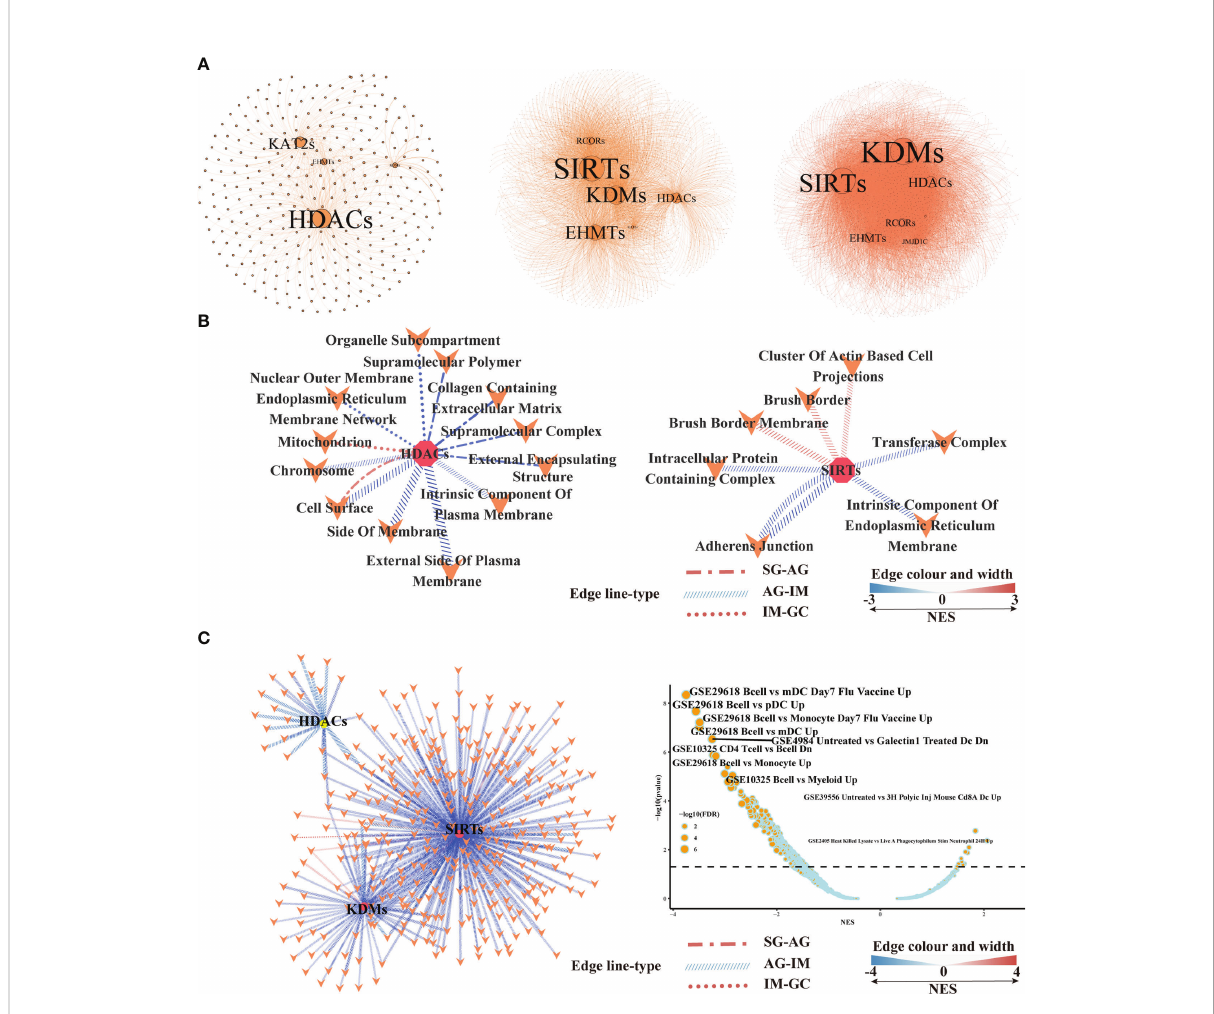
FIGURE 6 Gene set enrichment analysis based on the histone modi fi cation genes and their co-expressing genes in bulk RNA-seq transcriptome. (A) Networks illustrating co-expressing genes of histone modi fi cation genes at SG-AG (left), AG-IM (middle), and IM-GC (right). (B) Network showing the enriched gene sets based on the co-expressing genes of HDACs, SIRTs, and KDMs in different lesions. Only the signi fi cantly enriched gene sets against cellular component term in GO Ontology were shown here. Connection means signi fi cant enrichment. Edge line type represented the lesions, the color, and the width represented the scores of NES calculated by GSEA. (C) Network showing the enriched gene sets against immunologic signature database based on the co-expressing genes of HDACs, SIRTs and KDMs in different lesions. Connection means signi fi cant enrichment. Edge line type represented the lesions, the color, and the width represented the scores of NES calculated by